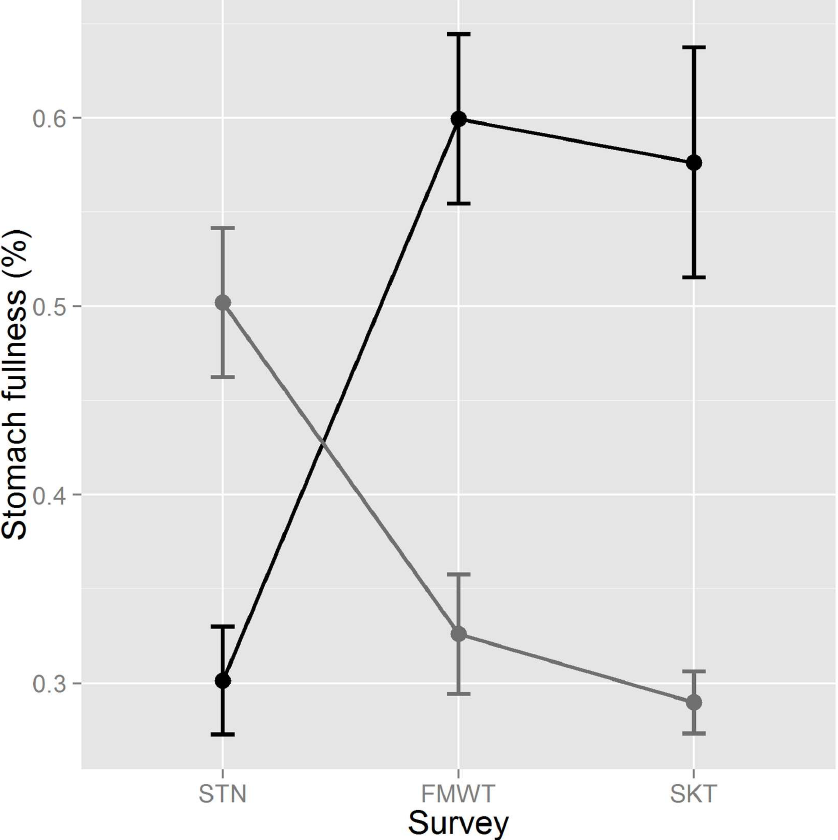
Fig 2. Mean stomach fullness (%) for Delta Smelt by survey and salinity. STN = Summer Townet, FMWT = Fall Midwater Trawl, SKT = Spring Kodiak Trawl. Grey represents stomach fullness of Delta Smelt sampledfrom freshwater ( < 0.55 psu) and black represents stomach fullness of Delta Smelt sampledfrom brackish habitat ( (cid:21) 0.55 psu). Mean differences betweenfreshwater and brackish habitat were significantfor each survey. Error bars are ± SE, n =